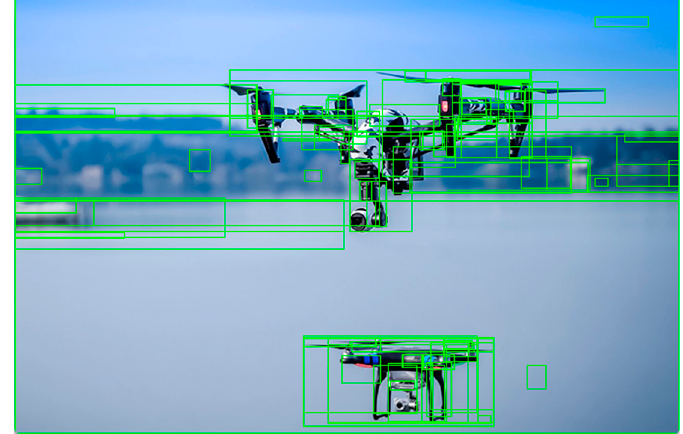
Figure 2. Selective searching in the image with drones.